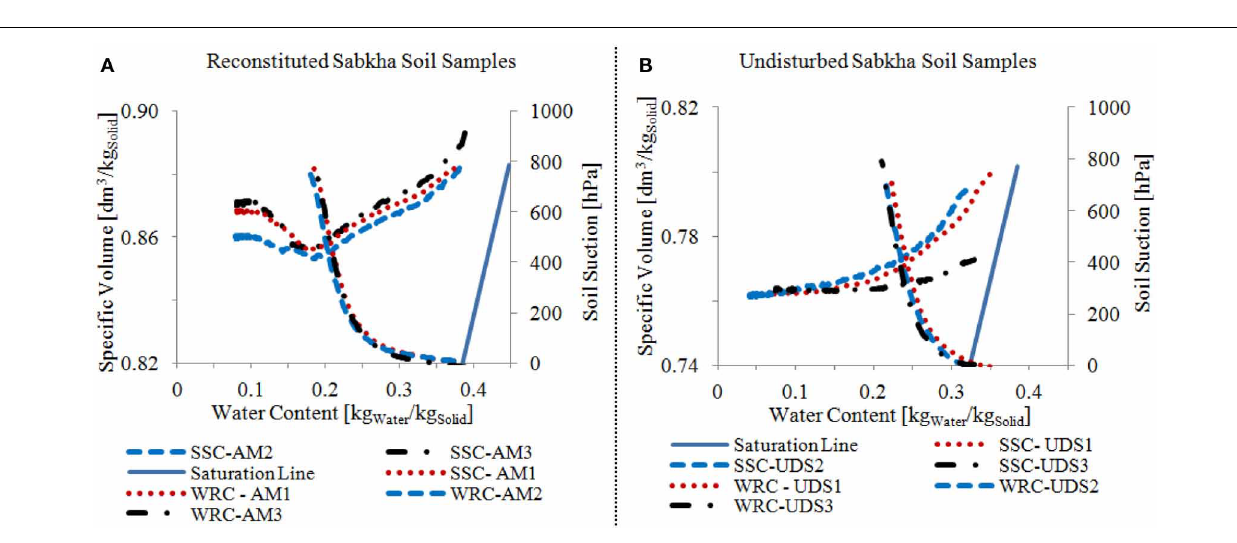
the undisturbed Sabkha soil samples “0.76–0.8” (i.e., the range